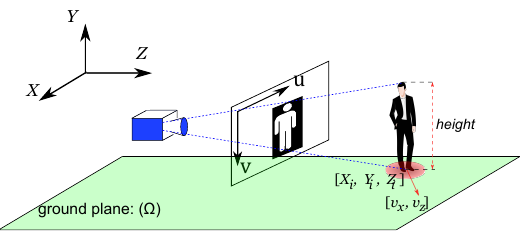
Figure 2. Pedestrian localization in 3D space by intersecting the detection with the ground plane. The stereo pair is embedded for the sake of